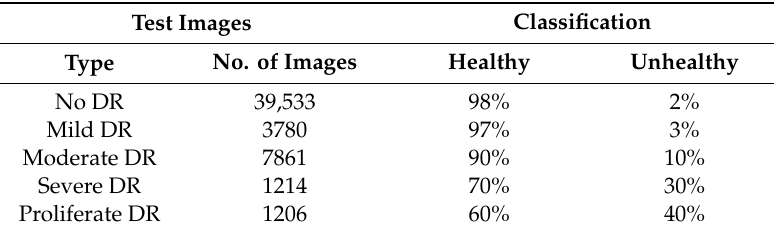
Table 6. Results from the Ca ff e model.